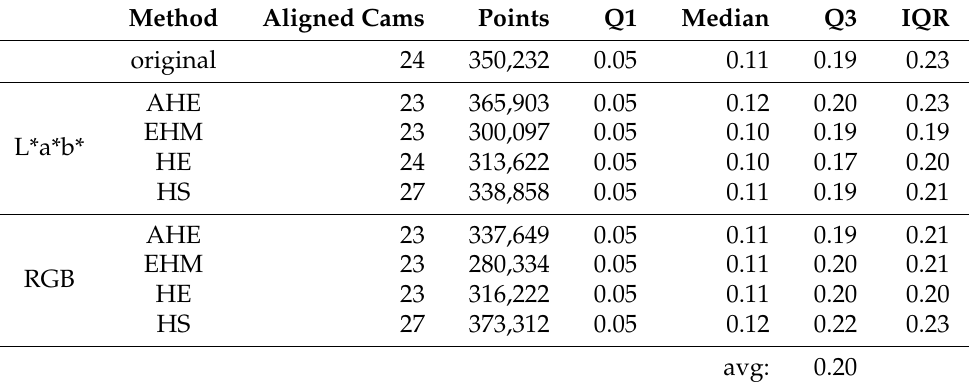
Table 1. Number of points and statistical measures for the reconstruction of the porcelain